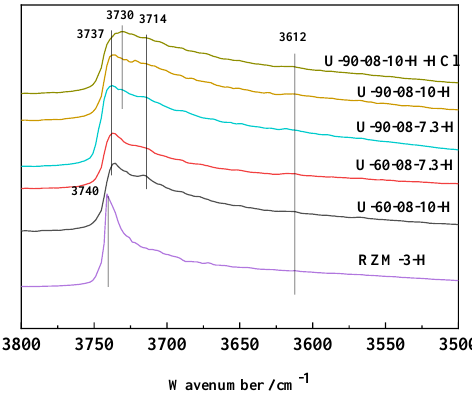
Figure 6. The OH-IR spectra of samples.